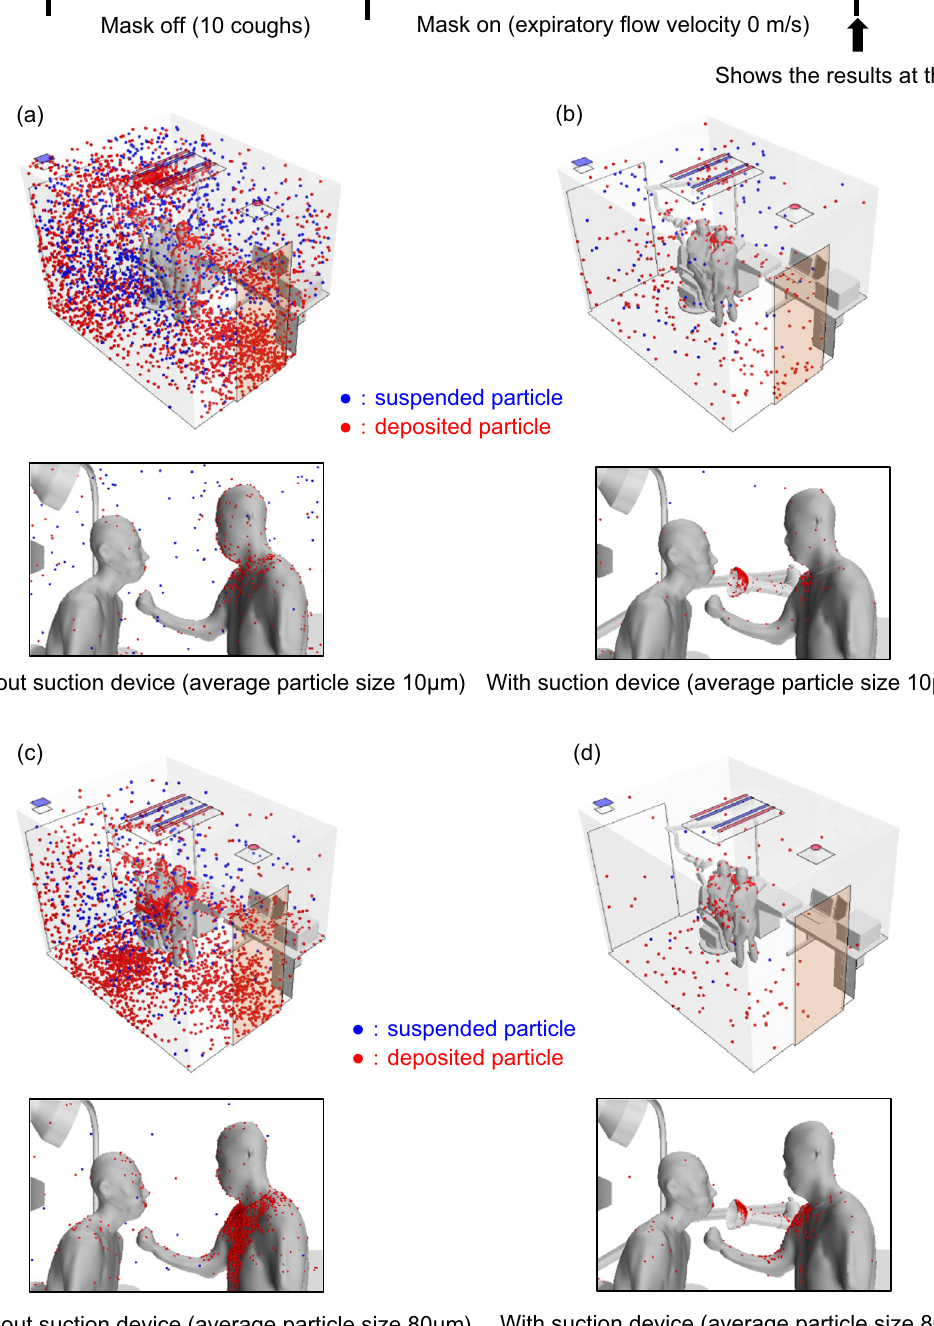
Figure 2. Simulation of suspended (blue) and deposited (red) particle distributions 30 s after the patient completes 10 consecutive coughs modeled by the air velocity profile shown in Fig. 1 (Case Y) and assuming no evaporation, in the presence and absence of a suction device positioned as shown in this figure. ( a ) Without suction device; average particle diameter, 10 μm. ( b ) With suction device; average particle diameter, 10 μm. ( c ) Without suction device; average particle diameter, 80 μm. ( d ) With suction device; average particle diameter, 80